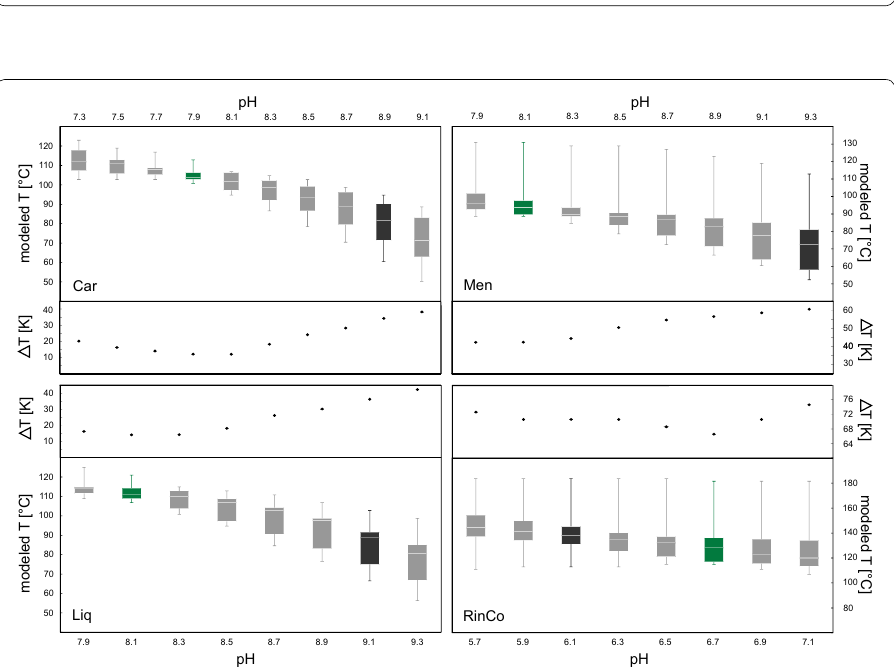
Fig. 7 Distribution of temperatures for selected geothermal springs of Villarrica area (Car, Men, Liq, RinCo) calculated by multicomponent geothermometry together with the according maximum temperature spreads ( ΔT ) plotted versus solution pH. Measured pH is indicated in dark grey , most likely pH in